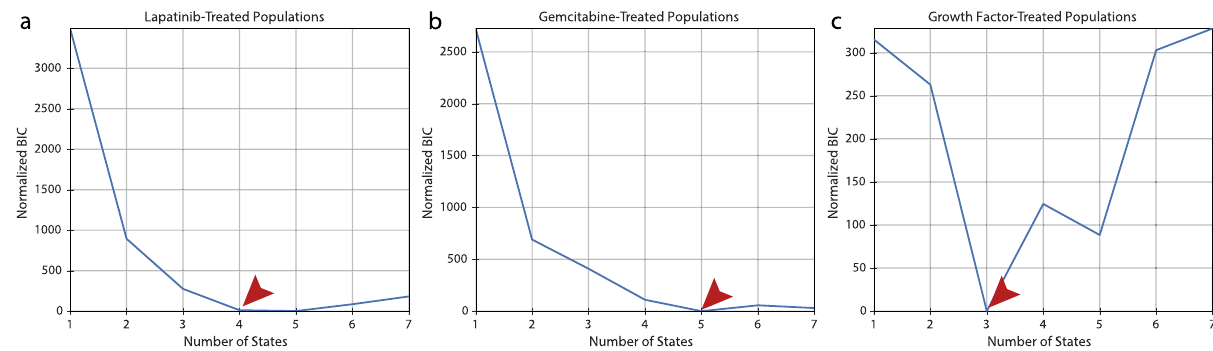
Fig. 7 BIC-based model selection infers the number of phenotypically distinct states. Normalized BIC values for ( a ) AU565 cells in control and treated with 5 nM, 25 nM, and 250nM of lapatinib; ( b ) AU565 cells in control and treated with 5 nM, 10 nM, and 30 nM of gemcitabine; and ( c ) MCF10A cells treated with PBS, 10 ng/ml EGF, 40 ng/ml HGF, and 10 ng/ml OSM. The BIC values for all conditions were normalized such that the minimum value was zero. The arrows in ( a – c ) point to the optimal number